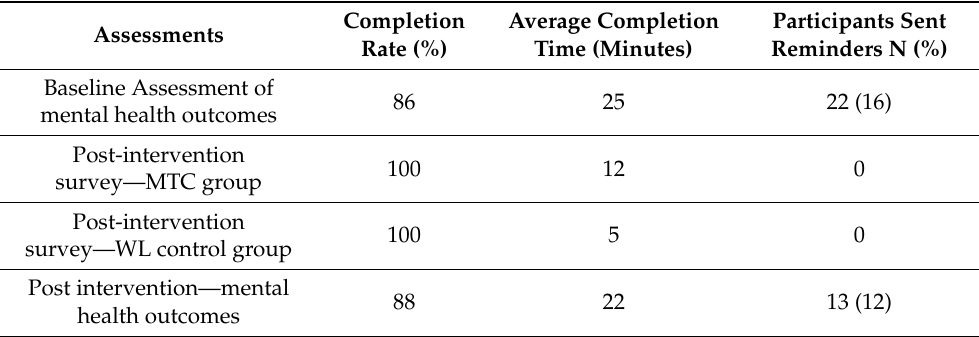
Table 3. Online data collection of all assessments with completion rate, completion time, and reminders for